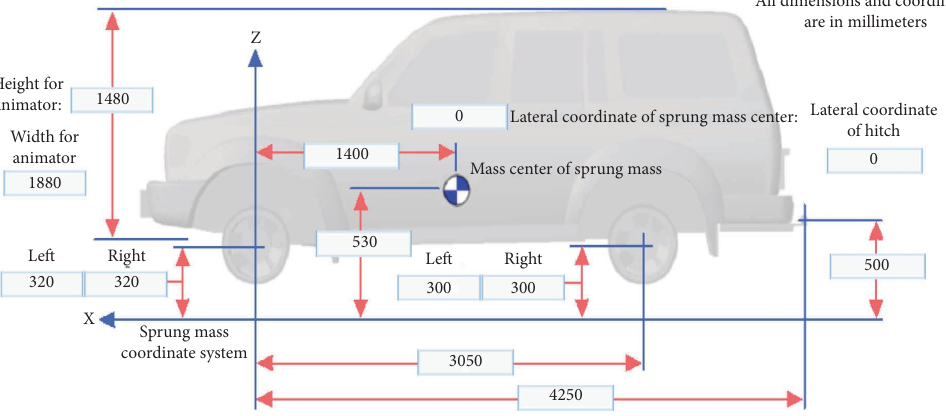
Figure 3: Dimensions and mass of E-class sedan.